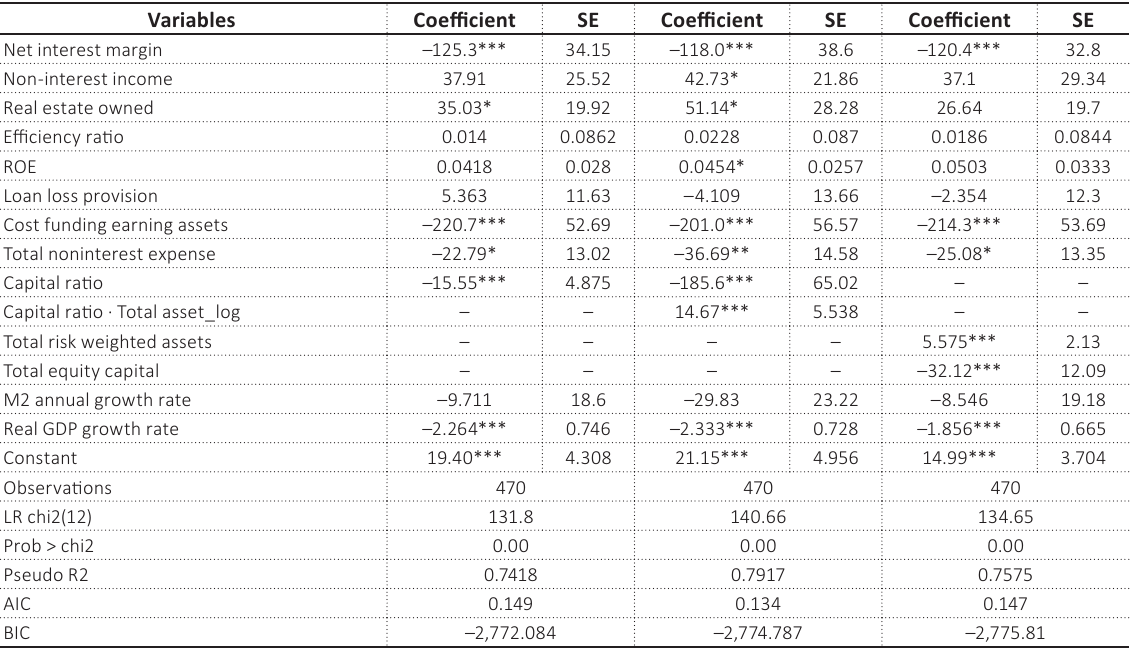
Table 5. Logit model regression